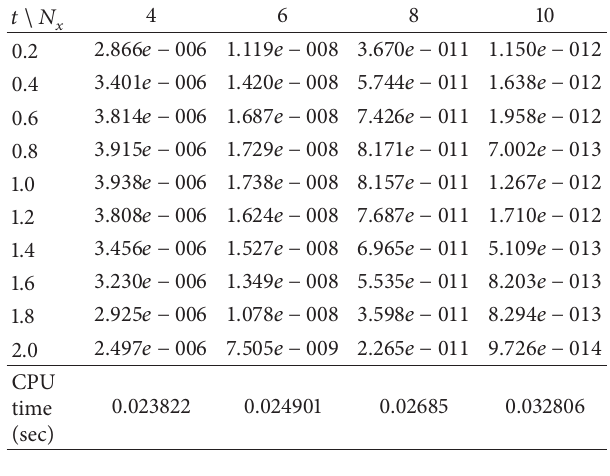
Table 10: Maximum errors 𝐸 𝑁 for the Burgers-Huxley equation when 𝛾 = 0.5 , 𝛽 = 1 , and 𝑁 𝑡 = 10